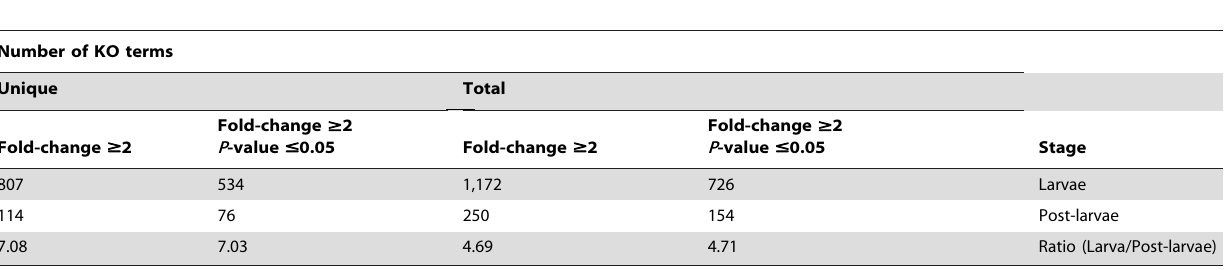
Table 2. Number of KO terms assigned to differentially represented transcripts in the M. rosenbergii developmental transcriptomic